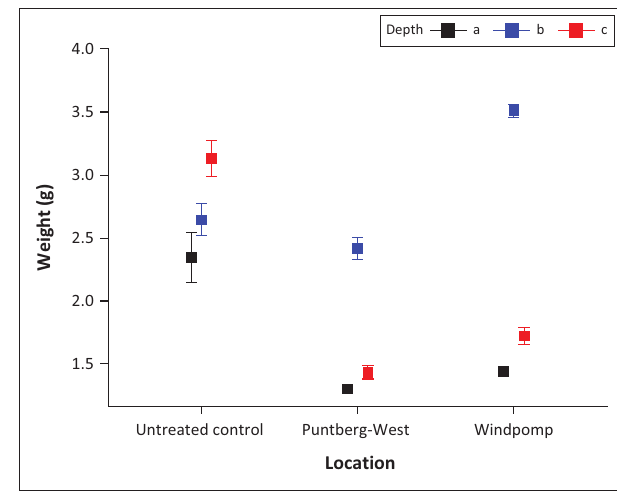
FIGURE 4: Growth response (seedling weight) of tomato cultivar Heinz 1378 on soil collected from three depths (‘a’ = 0 cm – 30 cm; ‘b’ = 30 cm – 60 cm); ‘c’ = 60 cm – 90 cm) of the soil profile at three locations (Puntberg-West; Windpomp; untreated control).